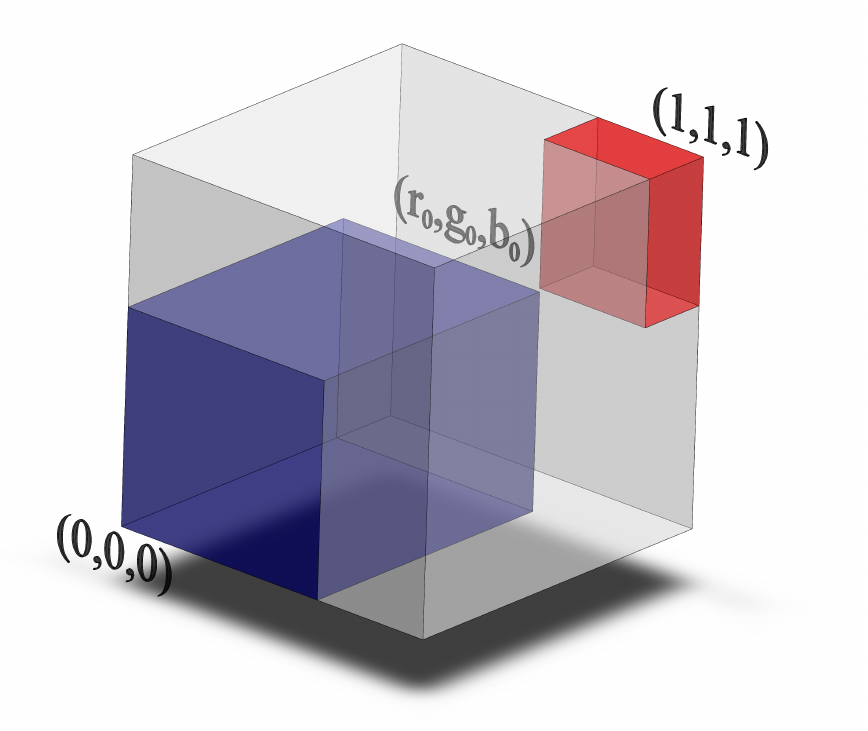
Figure 1. Product order in the RGB space: A generic colour ( r 0 , g 0 , b 0 ) dominates all the colours in the blue volume and is dominated by all the colours in the red